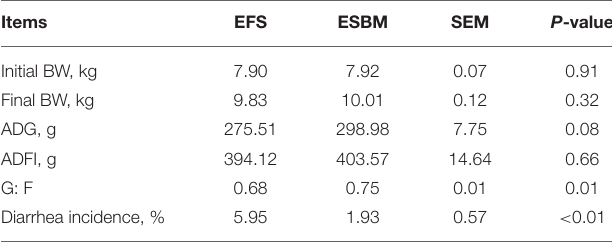
TABLE 3 | Effects of protein source on performance of weaned pigs. TABLE 4 | Effects of protein source on apparent ileal digestibility of amino acids and nitrogen of weaned pigs (%).